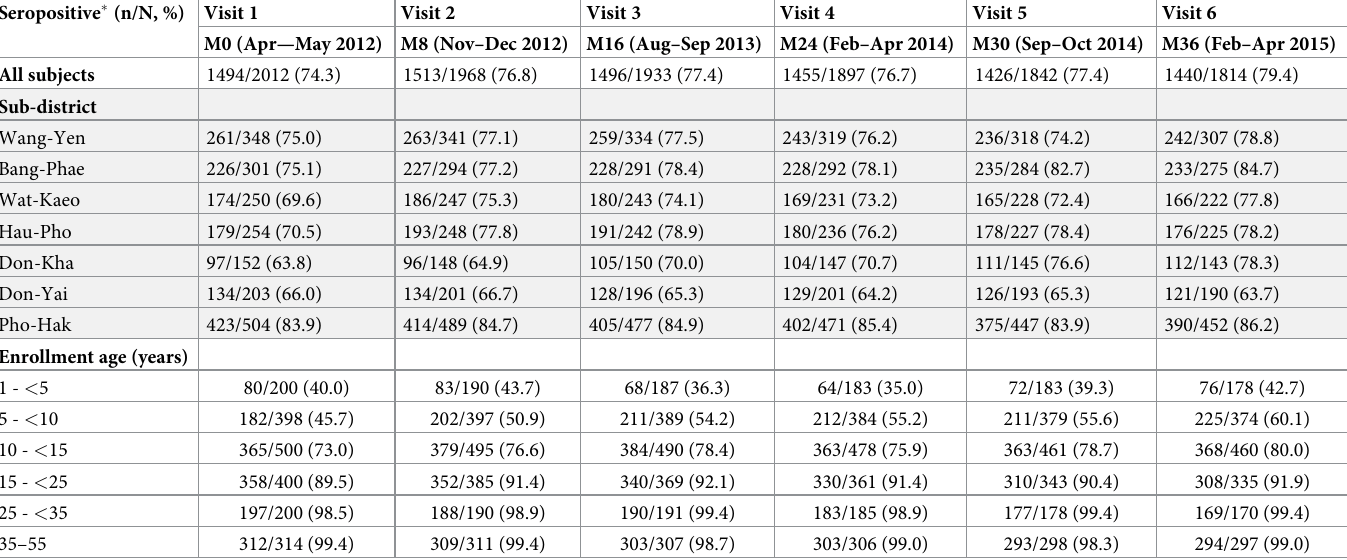
Table 3. Proportion of seropositivity (%) by residence (sub-district) and age at enrollment. Seropositive � (n/N, %) Visit